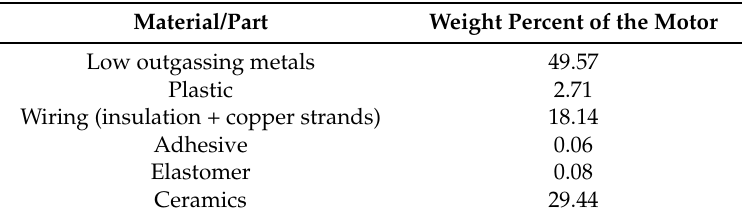
Table 1. Example breakdown of a high vacuum compatible L1B2 motor (Nanomotion HR4-1-U-1.5 UHV) into material types by